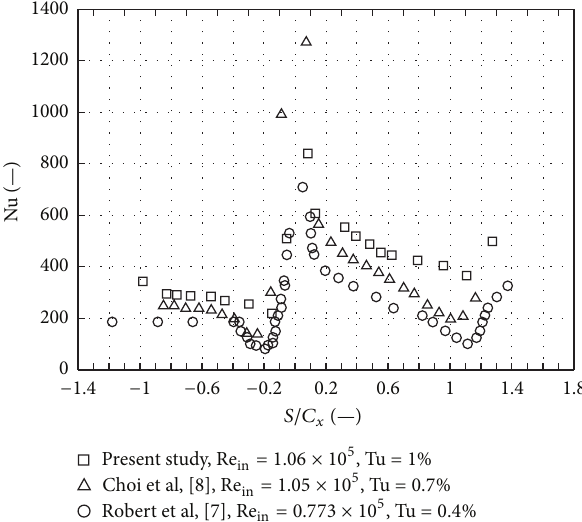
Figure 16: Comparison of local Nu distributions at midspan